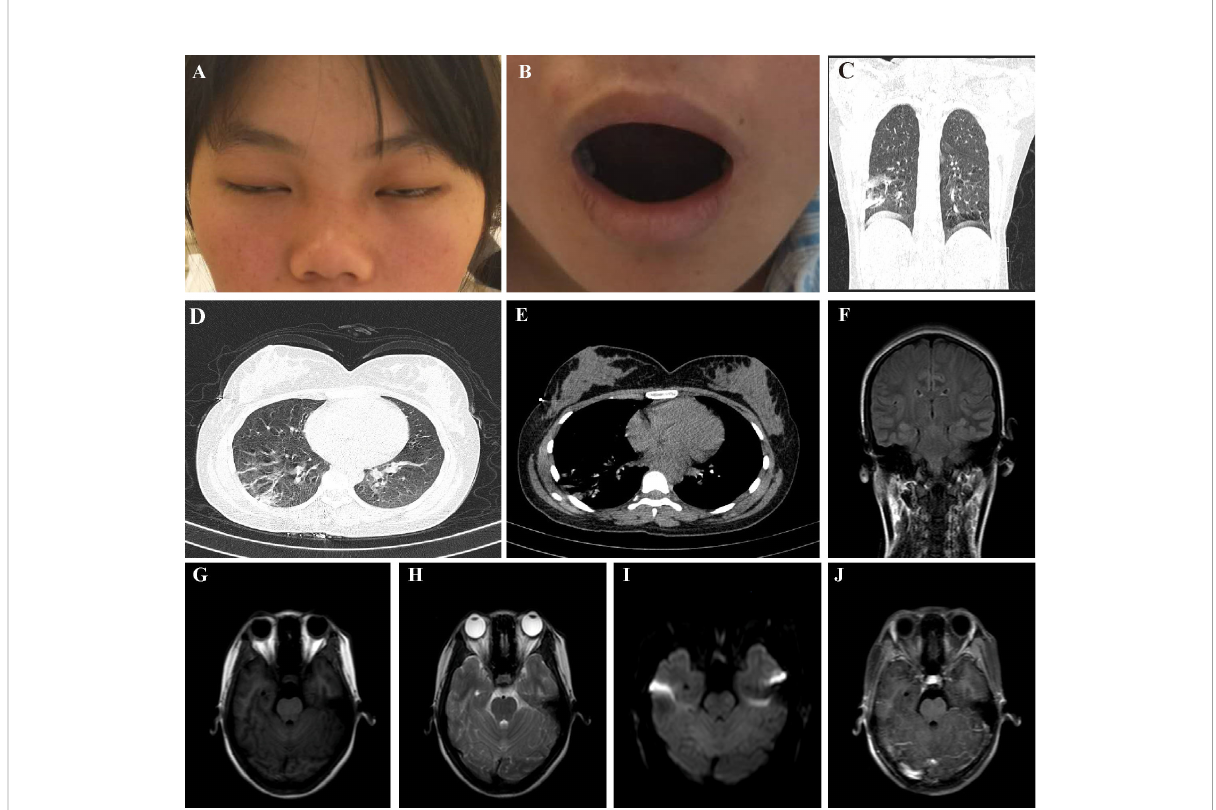
FIGURE 1 Clinical examination reveals dysfunction of facial nerve and the motor branch of the trigeminal nerve. (A) Bilateral facial weakness and Bell ’ s sign, (B) Limited mouth opening (tried the most effort to open her mouth); (C-E) . Multiple lesions in the lower lobe of the right lung; (F-J) . Head magnetic resonance imaging was